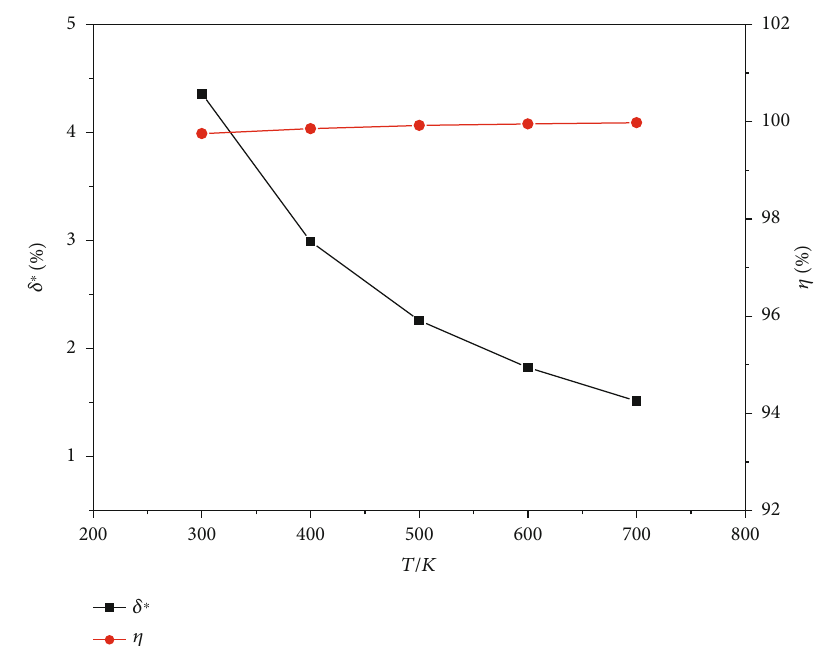
Figure 30: Total pressure loss and combustion e ffi ciency under di ff erent inlet